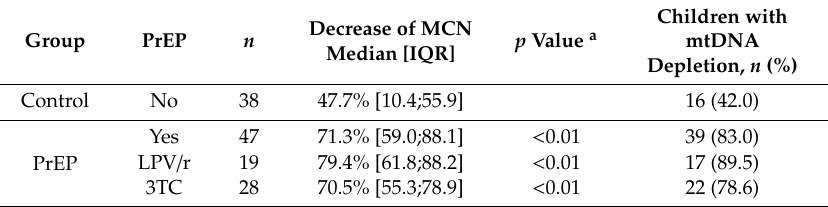
Table 6. Decrease of MCN between baseline (W6) and W26 and mtDNA depletion ( ≥ 50% reduction) in South African CHEU from the control group and the PrEP group.